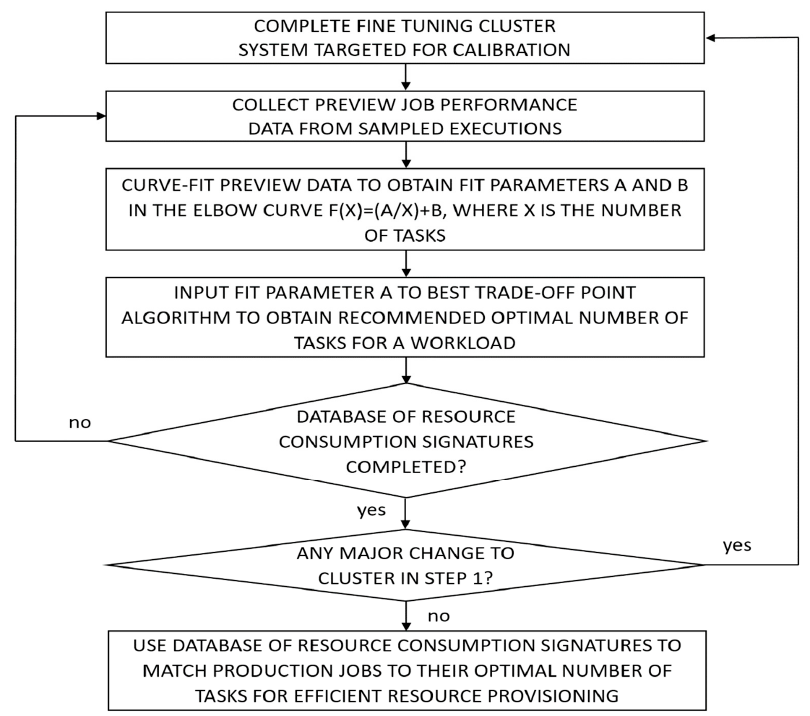
Figure 1. Flowchart of Best Trade-off Point (BToP) Method.